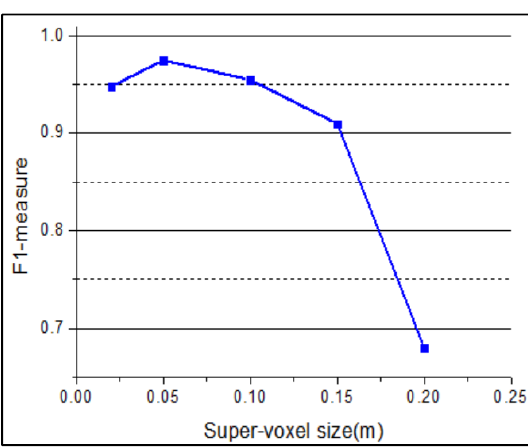
Figure 15. F1-measure achieved by proposed method with different sizes of super-voxel.